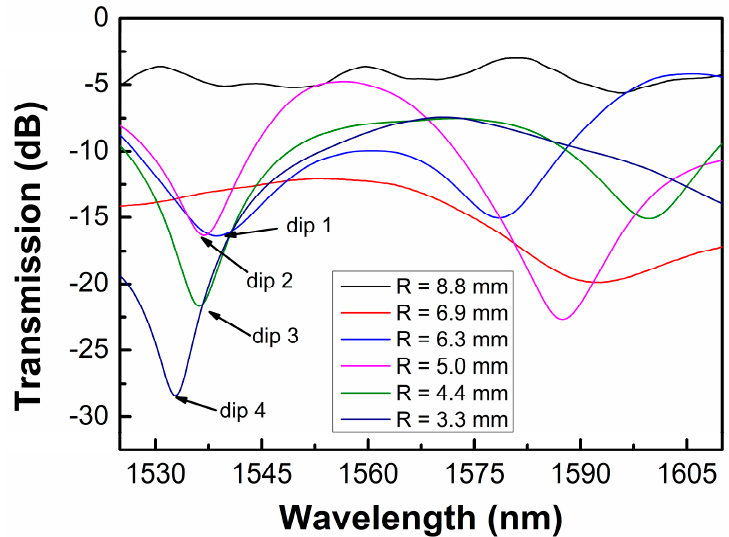
Figure 2. Transmission spectra of the bending fiber with different bending radii.